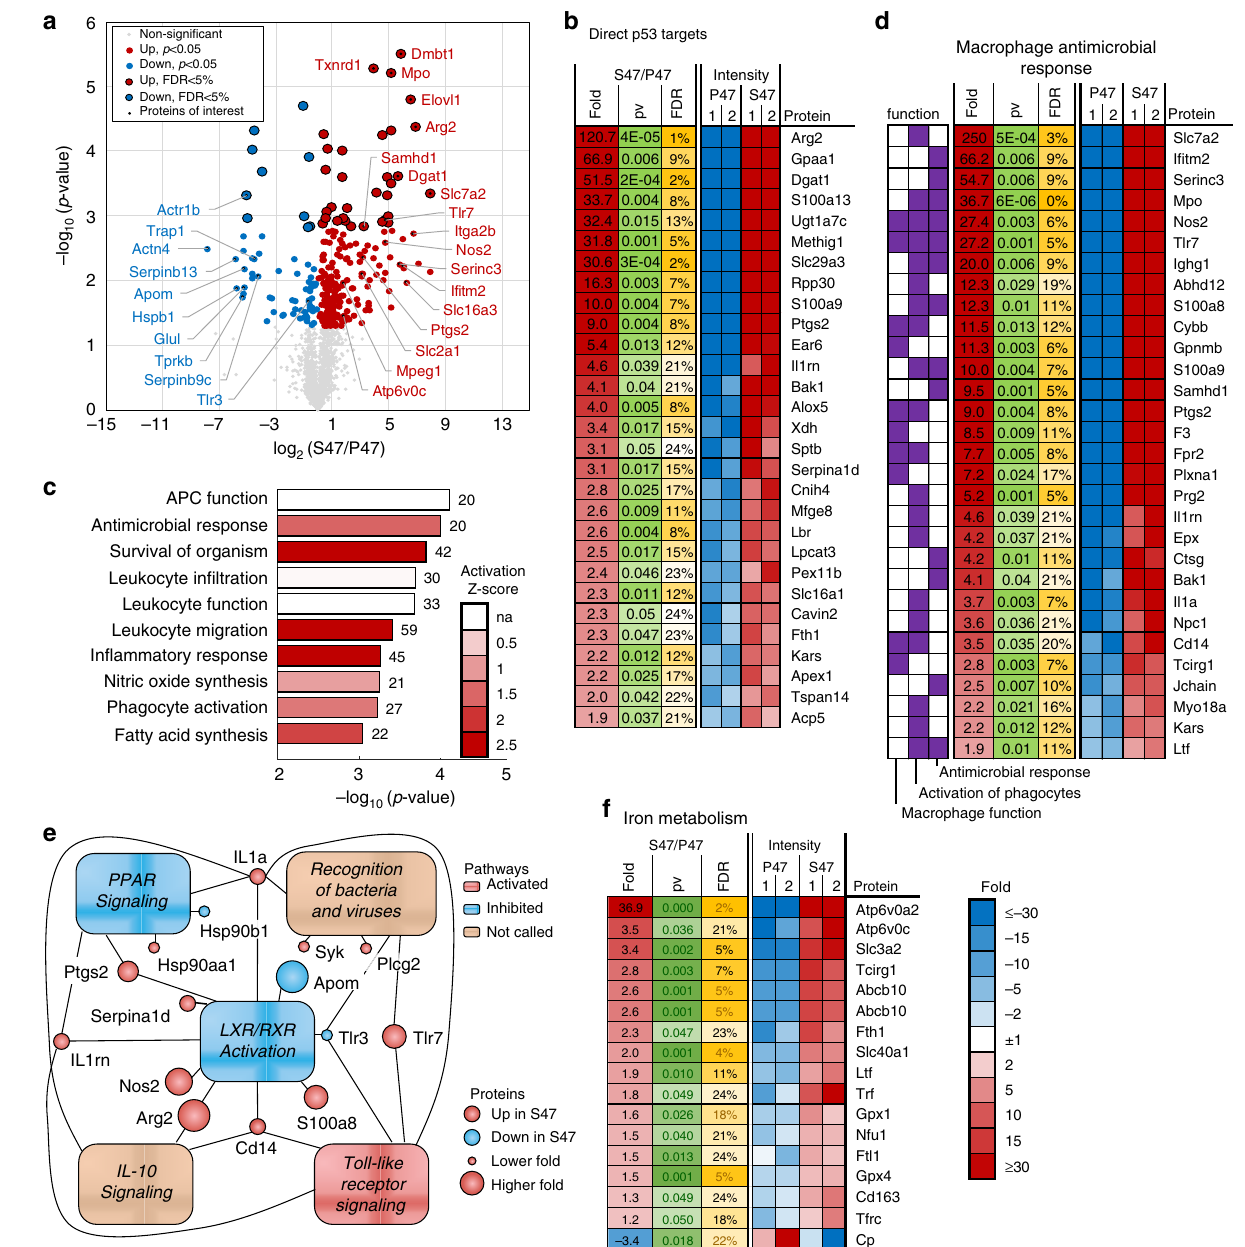
Fig. 4 Proteomic analysis of P47 and S47 MDMs. a Volcano plot of proteins differentially expressed by P47 and S47 MDMs. Proteins of interest most of which have eightfold or higher changes are highlighted. b Known p53 target proteins with signi fi cantly different expression in P47 and S47 MDMs. P < 0.05 (unpaired t test) and FDR <25%. c Signi fi cantly enriched functions. Bars indicate the − log 10 ( p value) with the number of proteins identi fi ed in each category next to the respective bar. The bars are color coded for their respective activation z scores. d Proteins important for macrophage innate immune response to bacterial infection are among the signi fi cantly enriched pathways in the proteomic screen P < 0.05 (unpaired t test) and FDR <25%. e Pathway analysis shows LXR/RXR activation and PPAR signaling pathways are suppressed in S47 MDMs. f Iron metabolism pathway proteins are signi fi cantly enriched in the proteomic screen P < 0.05 (unpaired t test) and FDR <25%. Source data are provided as a Source Data fi